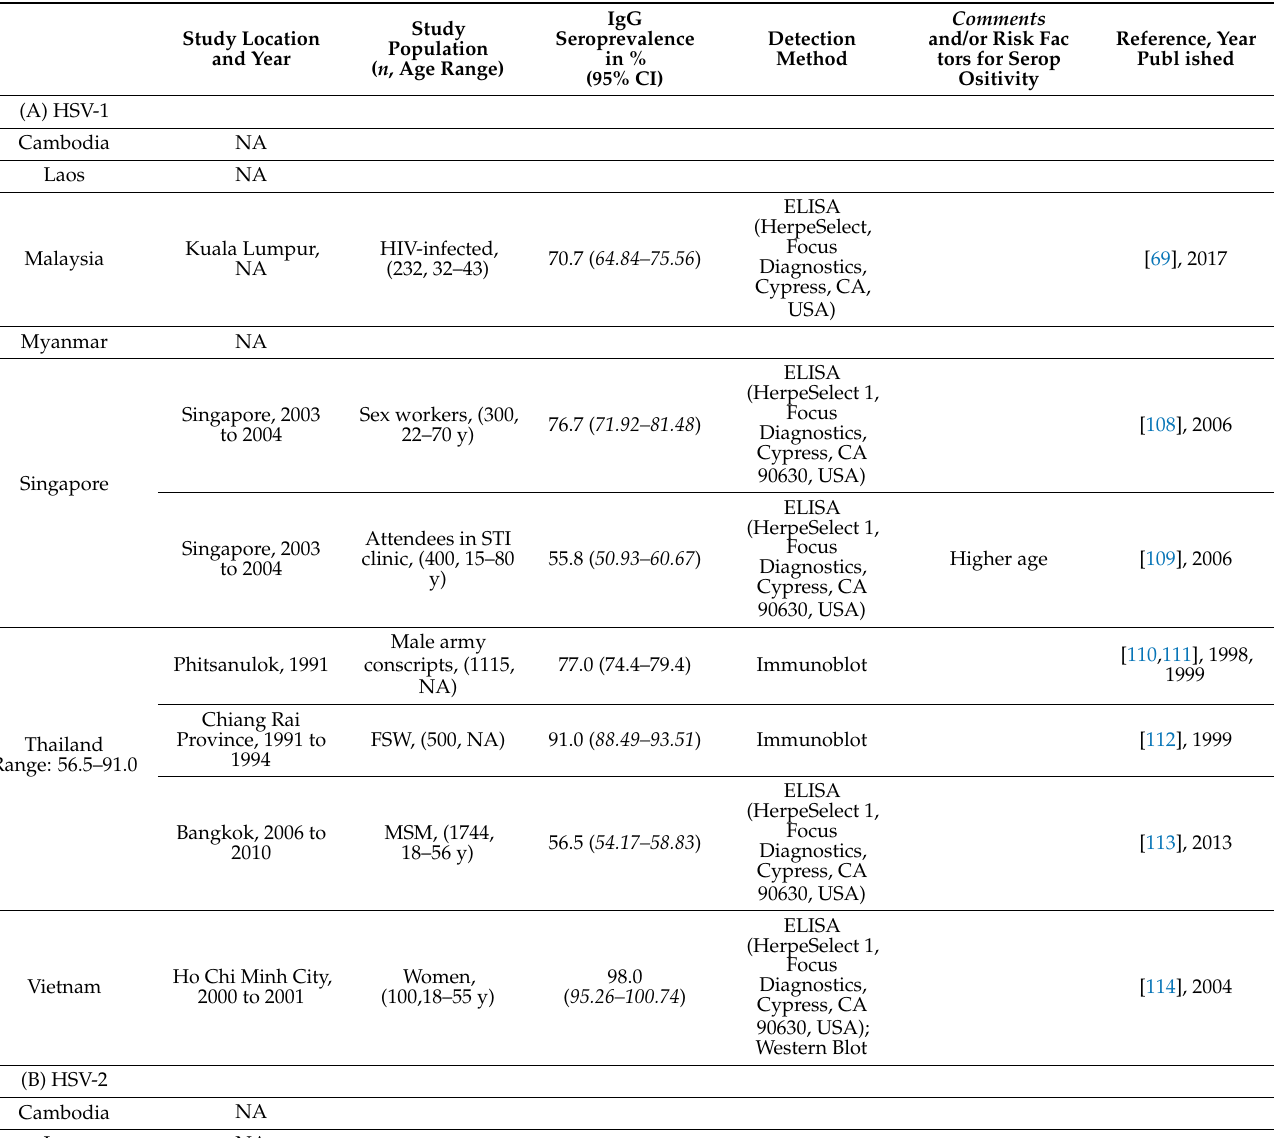
Table 7. HSV IgG serosurveys. Confidence Intervals (CI) in Italics estimated as described in Methods; ELISA = Enzyme- linked Immunosorbent Assay; FSW = Female sex worker; HSV = Herpes simplex virus; MSM = Men who have sex with men; STI = sexually transmitted infection; NA = not available; y =